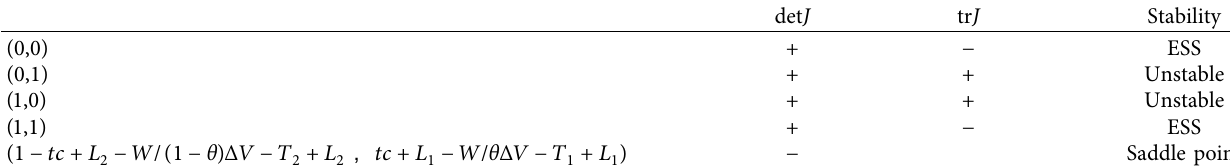
Table 2: Evolution and stability analysis of system